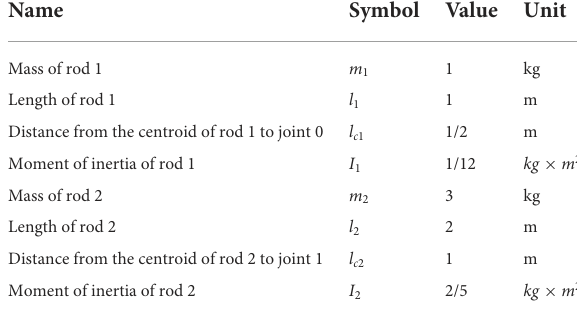
TABLE 1 Physical parameters of master-slave robot double joint